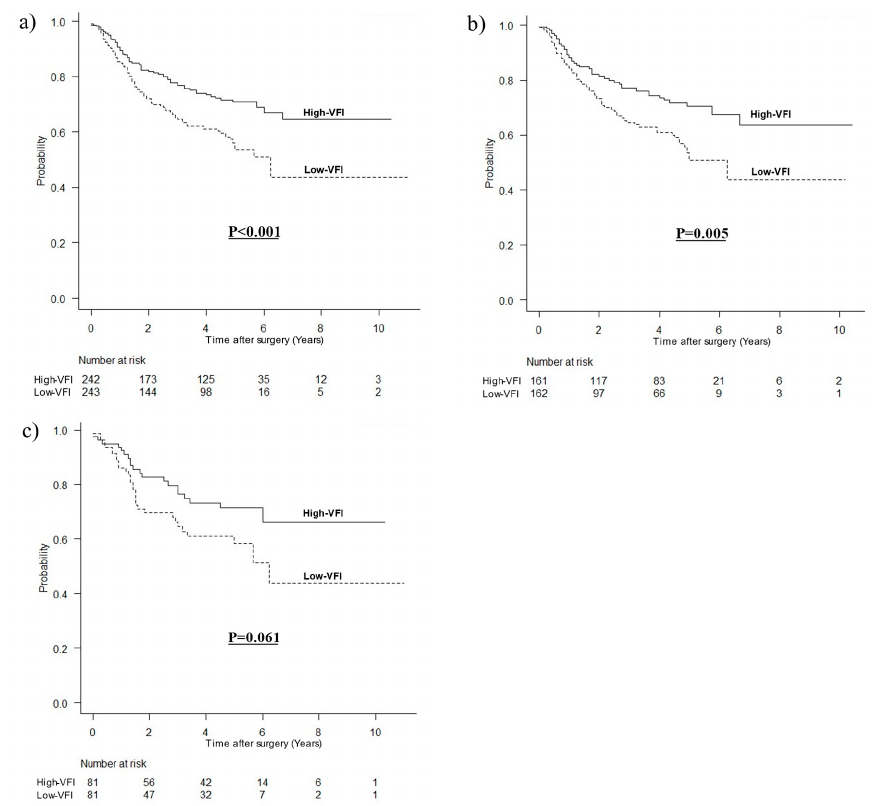
Figure 1. Kaplan–Meier survival curves for OS according to visceral fat mass. ( a ) OS for all patients ( p < 0.001), ( b ) OS for men ( p = 0.005), ( c ) OS for women ( p = 0.061).